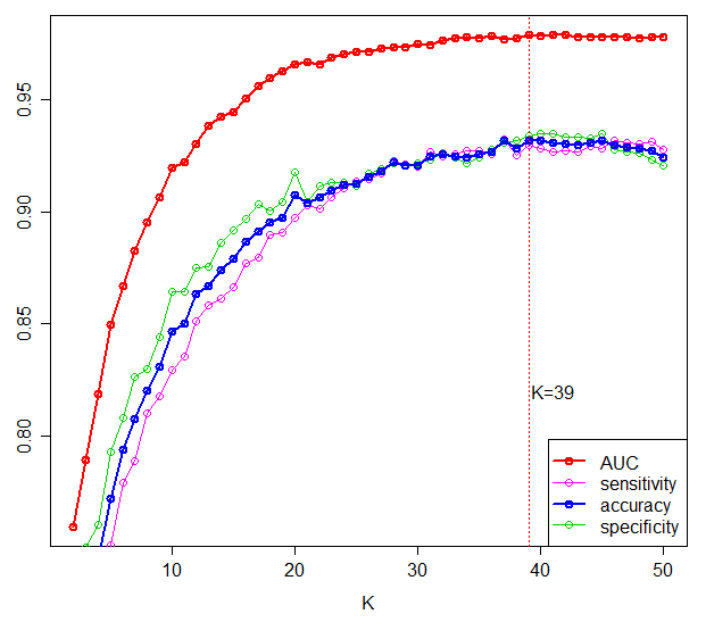
Figure 2. Predictive performance based on K top-ranked markers. From 200 repetitions of 5-fold cross validation, model prediction performance metrics, including area under the curve (AUC), sensitivity, and specificity, were averaged with specific K . Accuracy is the average of sensitivity and specificity. Table 2. The identified 39 PC-specific diagnostic markers.